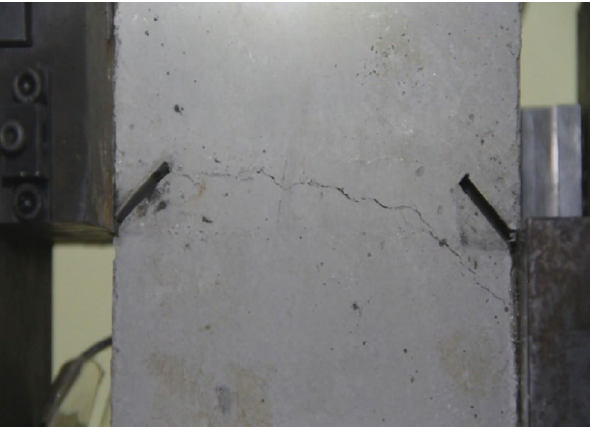
Figure 28. Photograph of a specimen showing fractures propagate in the middle of the rock